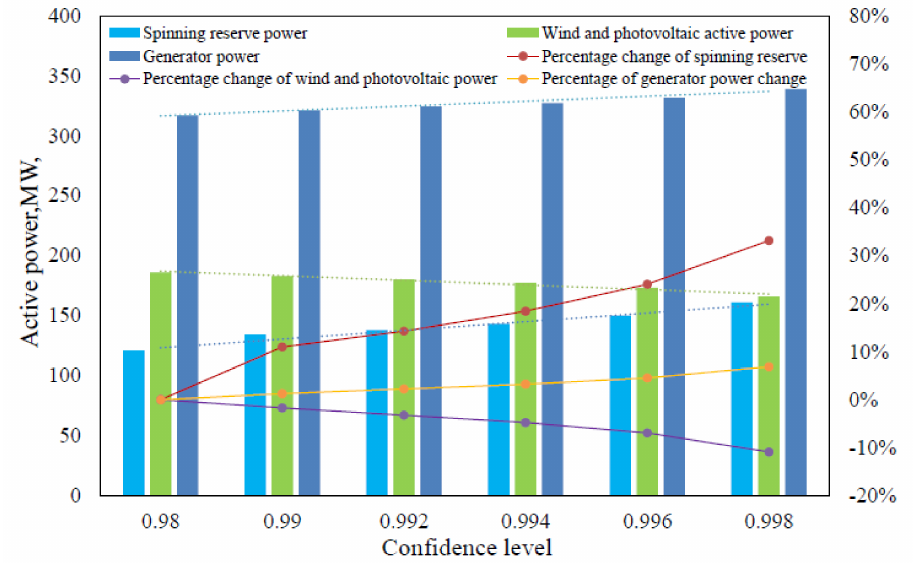
Figure 6. Variation of generator and wind power with different confidence